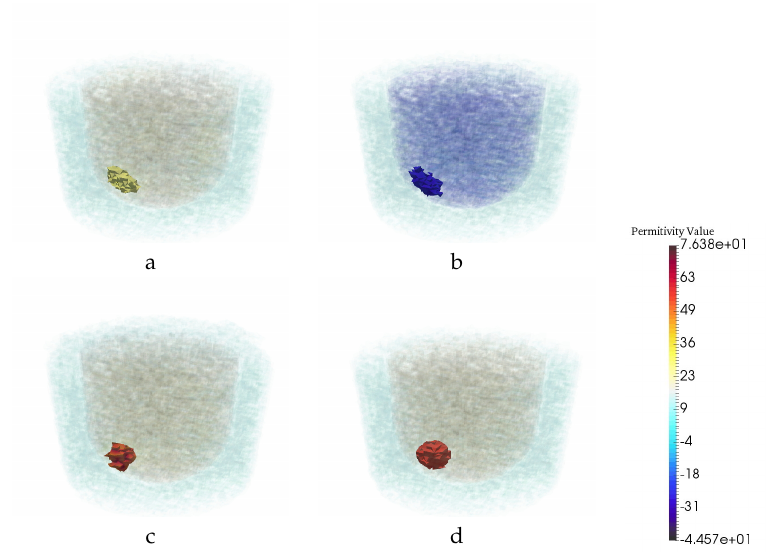
Figure 12. CNN performance for experimental result when the neural net was trained on Synthetic data. The real ( a ) and imaginary ( b ) part of CSI reconstruction. ( c ) CNN reconstruction. ( d ) Ground truth.